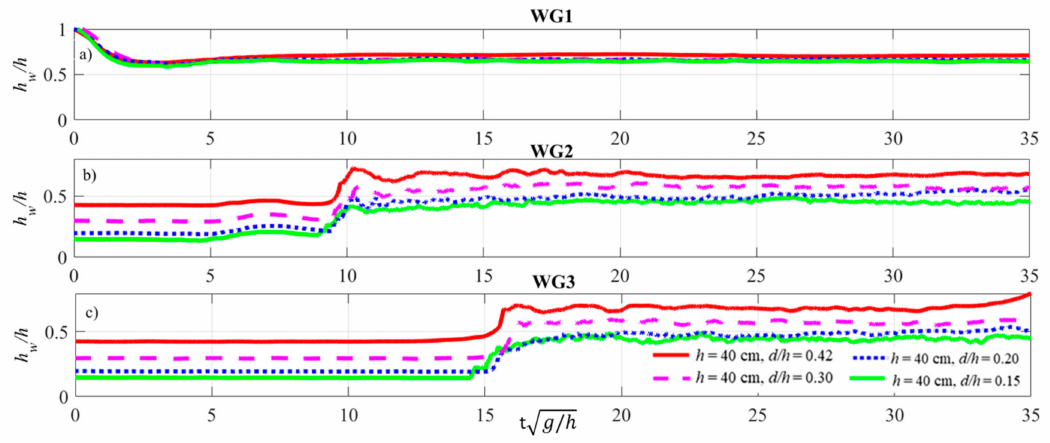
Figure 9. Wet bed bore water surface time history for h = 40 cm, di ff erent still water levels, d = 6, 8, 12, 17 cm, measured at location of ( a ) reservoir wave gauge (WG1), ( b ) x = 3.5 m (WG2) and ( c ) x = 5.5 m